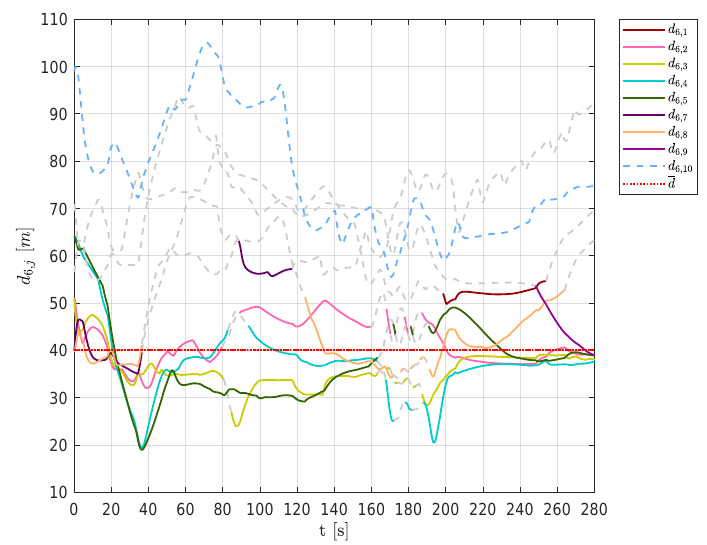
Figure 28. Scenario #3—10 aircraft: distances between UAV 6 and the other swarm vehicles. Solid lines are used for visible aircraft and dashed gray lines are employed whenever they are no longer visible, whereas dashed colored lines are used for never visible UAVs. The desired distance is highlighted using a dotted red line.